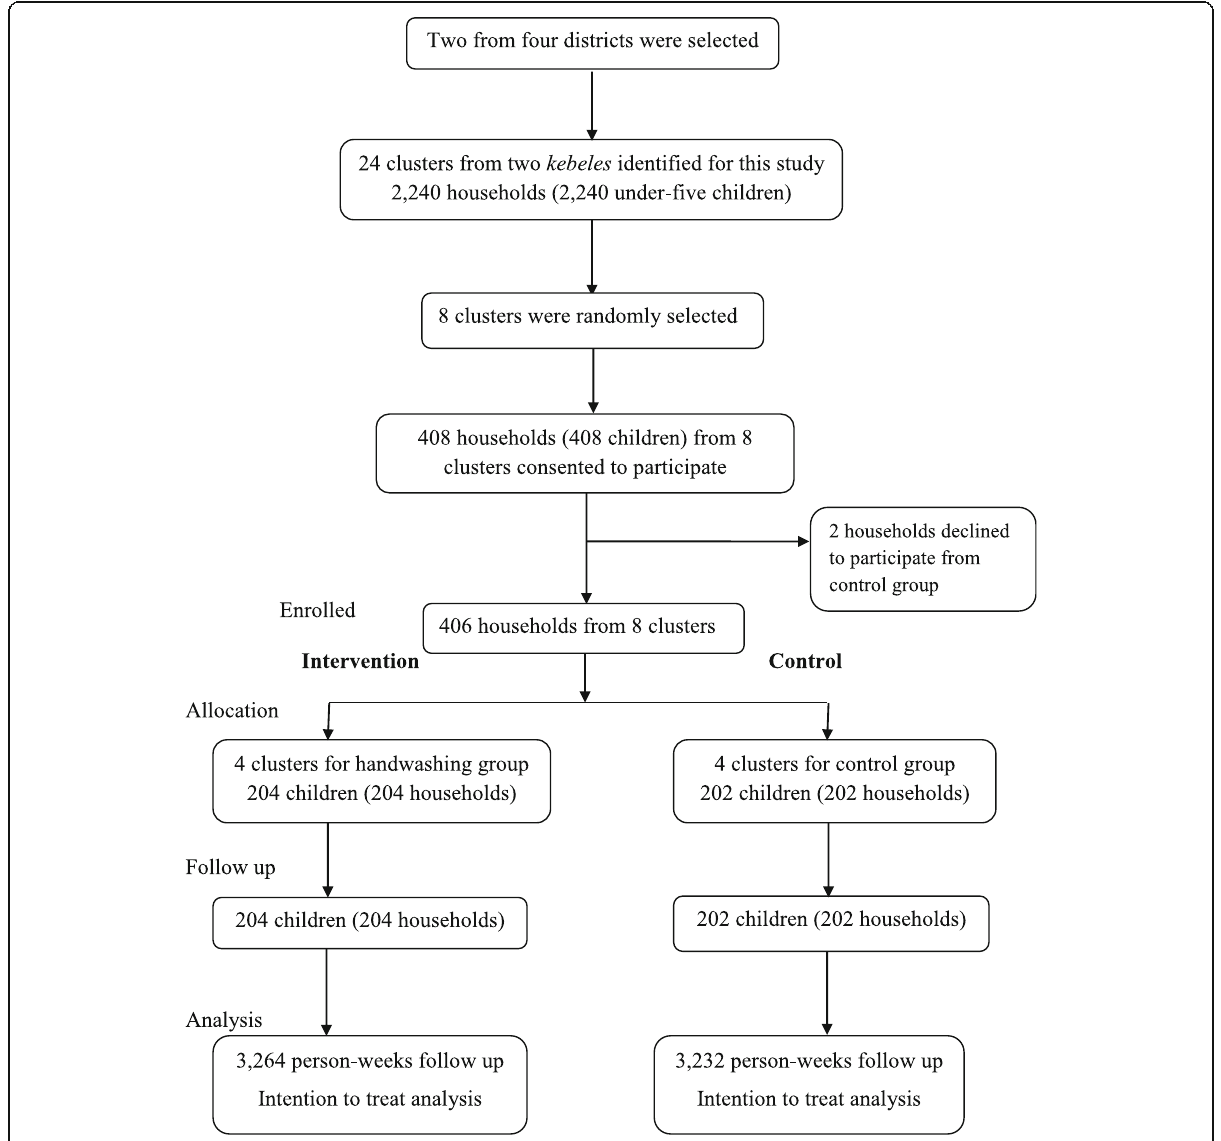
Fig. 1 Selection and follow-up flow of study participants for the community randomized controlled trial, rural Dire Dawa, eastern Ethiopia,